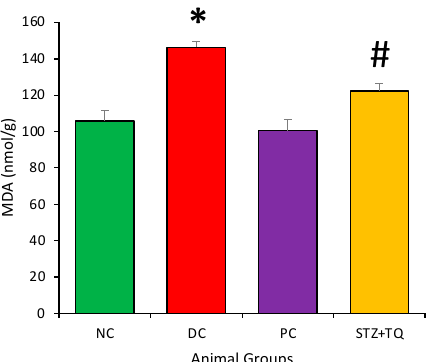
Figure 7. The lipid peroxidation, MDA level in different groups of rats after 8 weeks continued treatment. The experimental animals were uniformly divided into each group ( n = 8 per group). Data are means ± standard error of the mean (SEM). Groups: Normal control (NC); disease control (DC) i.e., STZ-treated group; positive control (PC) animal treated with STZ and Glibenclamide; diabetic rats treated with TQ (STZ + TQ). * p < 0.05 (significant difference of between DC vs. NC), # p < 0.05 (significant difference between DC vs. STZ + TQ).